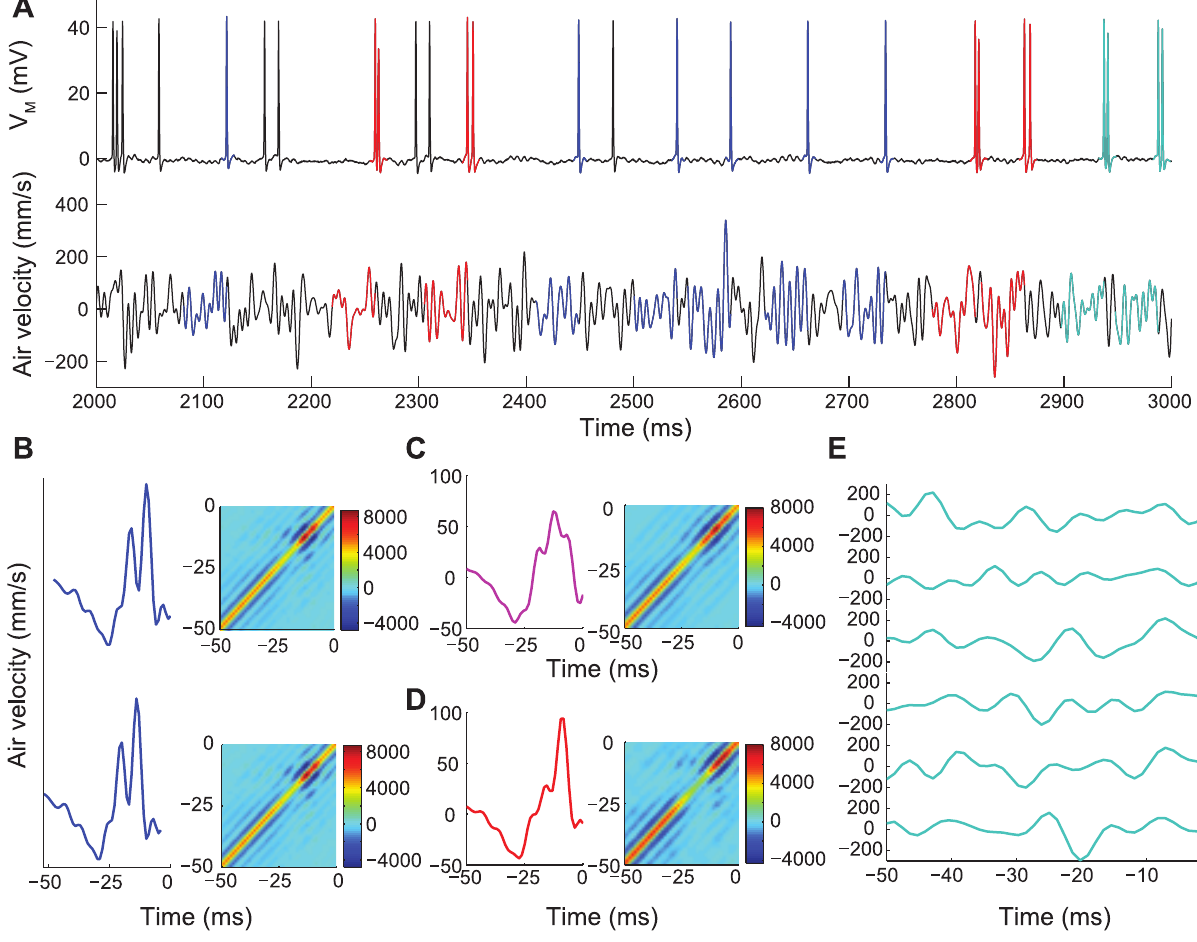
Figure 6. Schematic of modeling event-conditioned stimuli. A: Simultaneous recording of one second of GWN wind stimulus (bottom trace) and intracellular membrane potential (upper trace) from the same interneuron as in Figure 3. Well-isolated response patterns are divided into isolated single spike responses (blue) and , 2 ms doublets (red and cyan). Response patterns which either are not sufficiently isolated are not considered in subsequent analysis (black). The 50 ms of the stimulus preceding the second spike of the response pattern is highlighted in matching colors (bottom trace). B, Upper panel: Gaussian model of 50 ms of stimulus preceding an isolated single-spike response, consisting of a mean (blue, left panel) and covariance (right panel, color scale in mm 2 /sec 2 ) of the entire single-spike-conditioned stimulus ensemble (13,375 events from 30 minutes of recording). B, Lower panel: Same Gaussian model as in upper panel, offset by 2 ms. C: Synthetic Gaussian model of stimulus preceding 2 ms doublets, obtained by summing the means from panel B (cyan, left panel), and summing and then constraining the covariances (Eq. 6). D: Gaussian model (mean, red, and covariance) of 50 ms of stimulus preceding isolated doublet response patterns with 2 ms ISIs, based on 90% of the doublet- conditioned stimulus ensemble (2,652 events from 30 minutes of recording). E: Selection of 6 of the 294 stimulus samples which elicited a 2 ms doublet response and that were not used to build the Gaussian model in panel D, to later be used for likelihood testing.